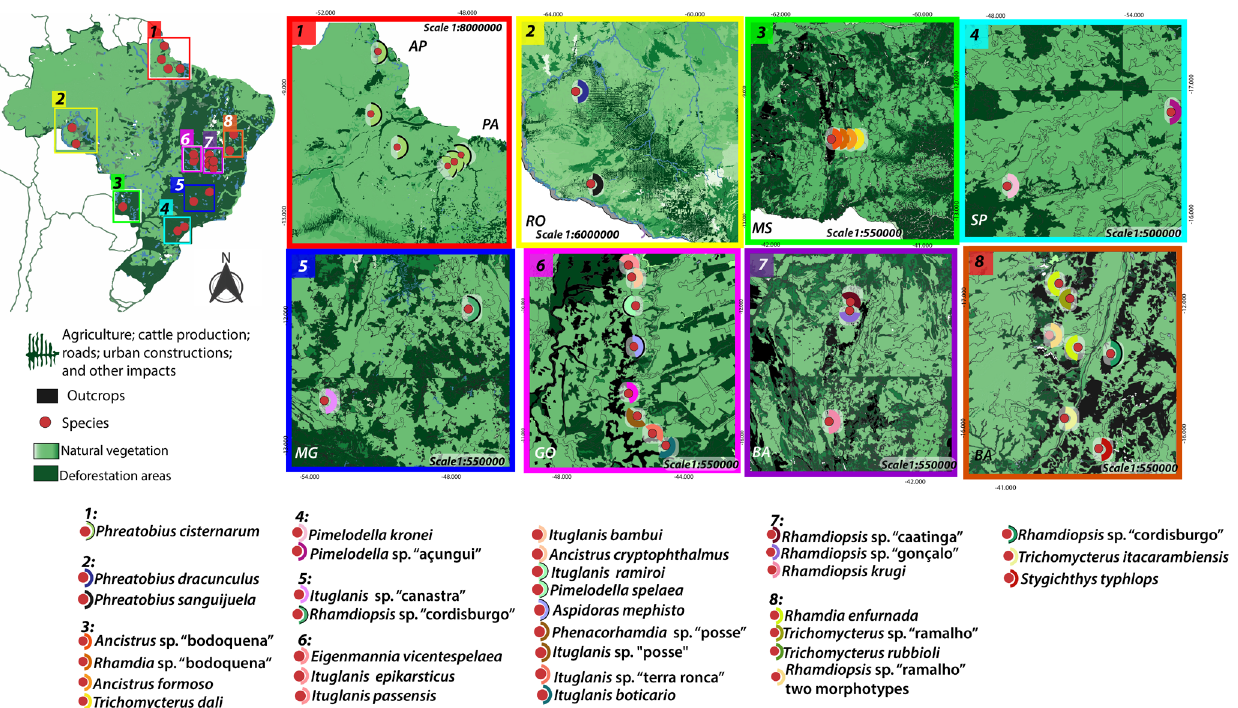
FIGURE 3 | Detailed maps showing the distribution of Brazilian subterranean fishes in different federated states, including vegetation and impacts nearby. AP, Amapá State; PA, Pará State; RO, Rondônia State; MS, Mato Grosso do Sul State; BA, Bahia State; SP, São Paulo State, MG, Minas Gerais State; GO, Goiás State. Outcrops, landscape areas with rocks and potentially cave